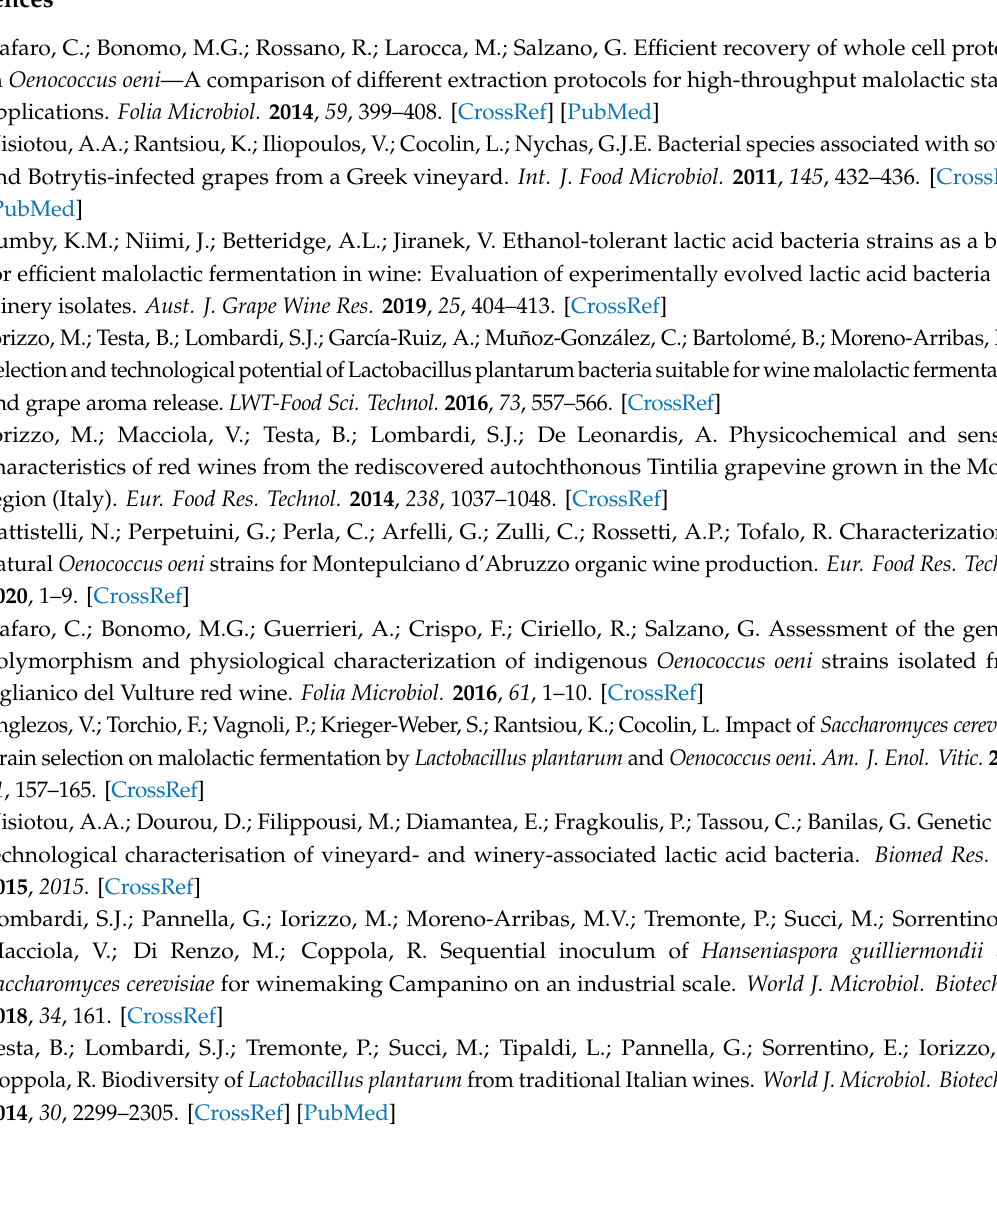
Table S1: Kinetic parameters obtained from the cultivation of high biofilm producer strains of L. plantarum in planktonic